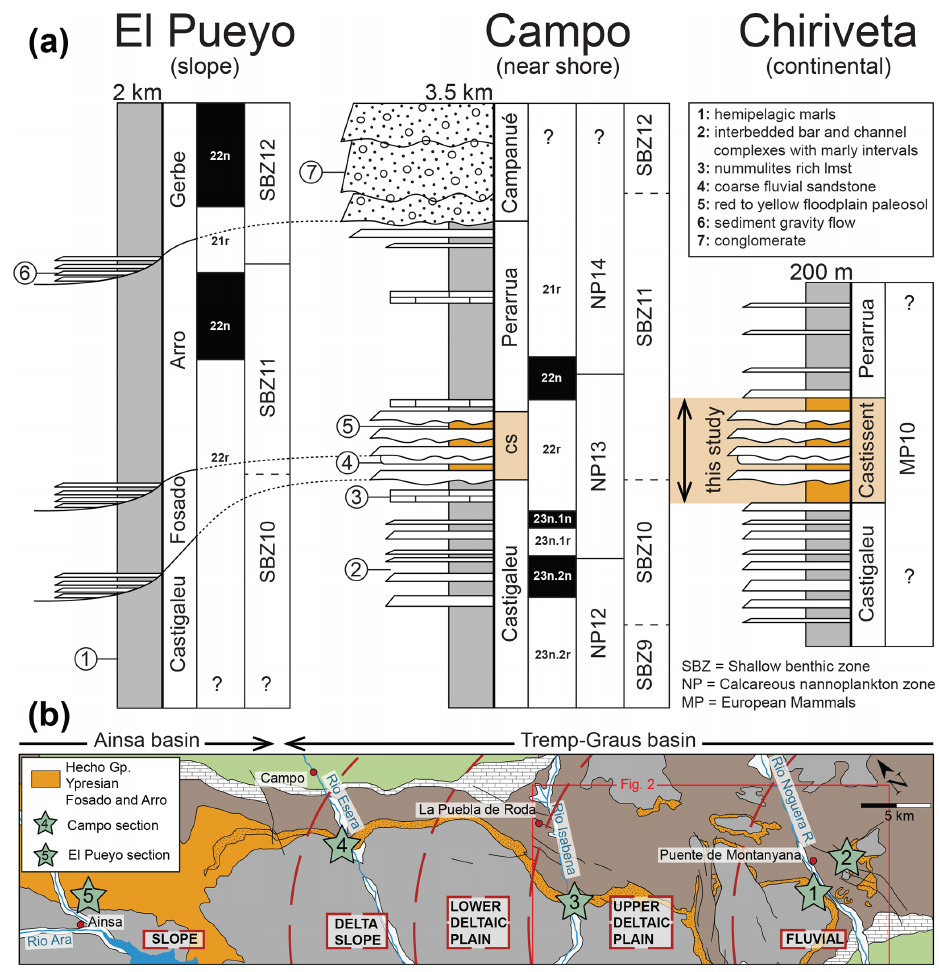
Figure 3. (a) Time constraints on the Castissent Fm. MP zone from the continental section from Checa Soler (2004) and Payros et al. (2009). SBZ and NP in the Campo section from (Schaub, 1966, 1981; Kapellos and Schaub, 1973; and Tosquella, 1995), magnetostratigraphy from Bentham and Burbank (1996). SBZ in El Pueyo section from Payros et al. (2009). Magnetostratigraphy in El Pueyo from Poyatos- Moré (2014). (b) Extended map of the study area. For map legend and references, see Fig.